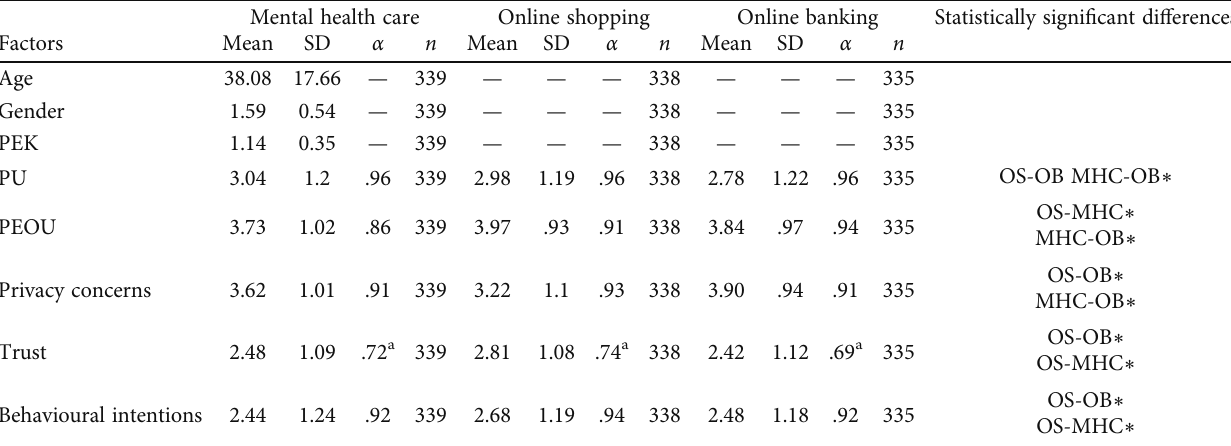
Table 1: ANOVA, descriptive, and reliability